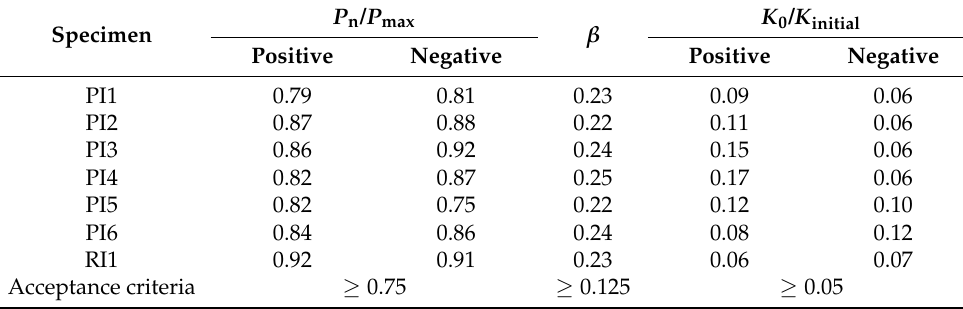
Table 7. Test results for comparison with acceptance criteria in ACI